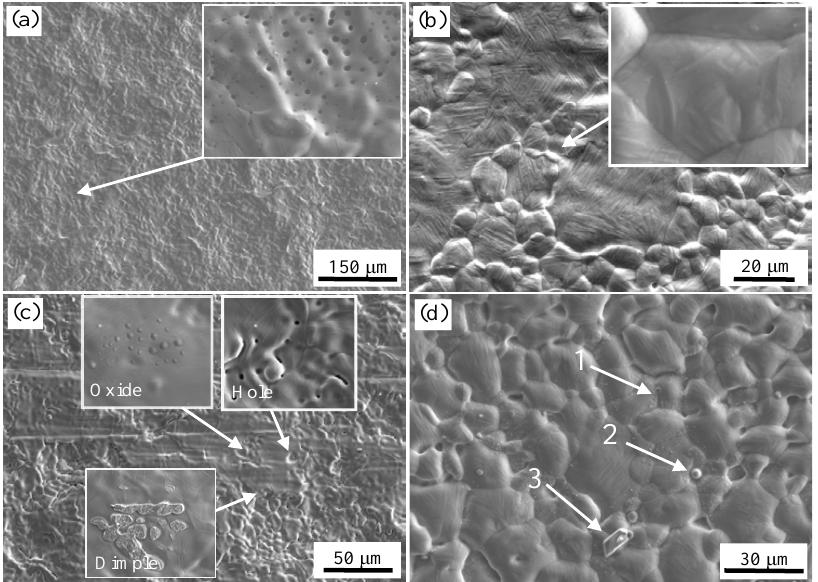
Figure 4. Surface morphology of stainless steel and carbon steel under different surface treatments after high temperature oxidation experiment; After brush grinding ( a ) stainless steel side; ( b ) carbon steel side and after pickling ( c ) stainless steel side; ( d ) carbon steel side.